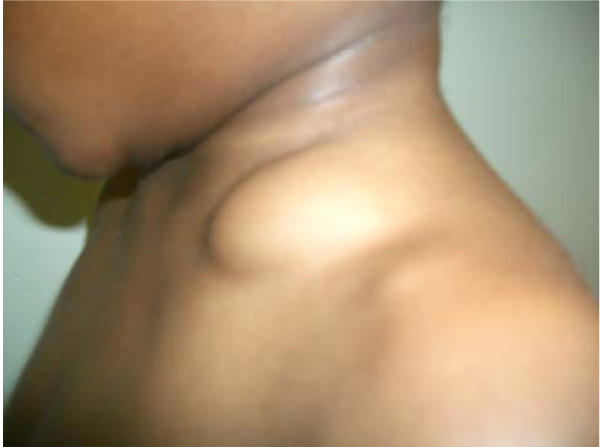
Photographs of the child at age 5, showing massive lymphadenopathy.